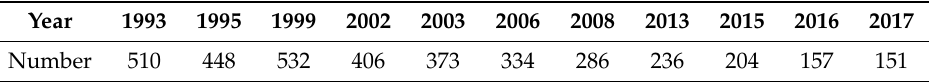
Table 3. Number of Postulants from 1993 to 2017.